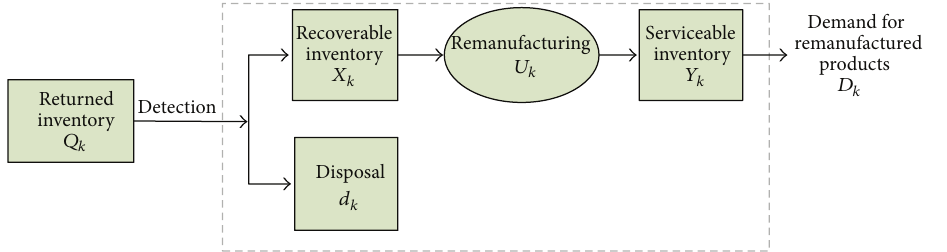
Figure 1: Inventory control framework of a remanufacturing